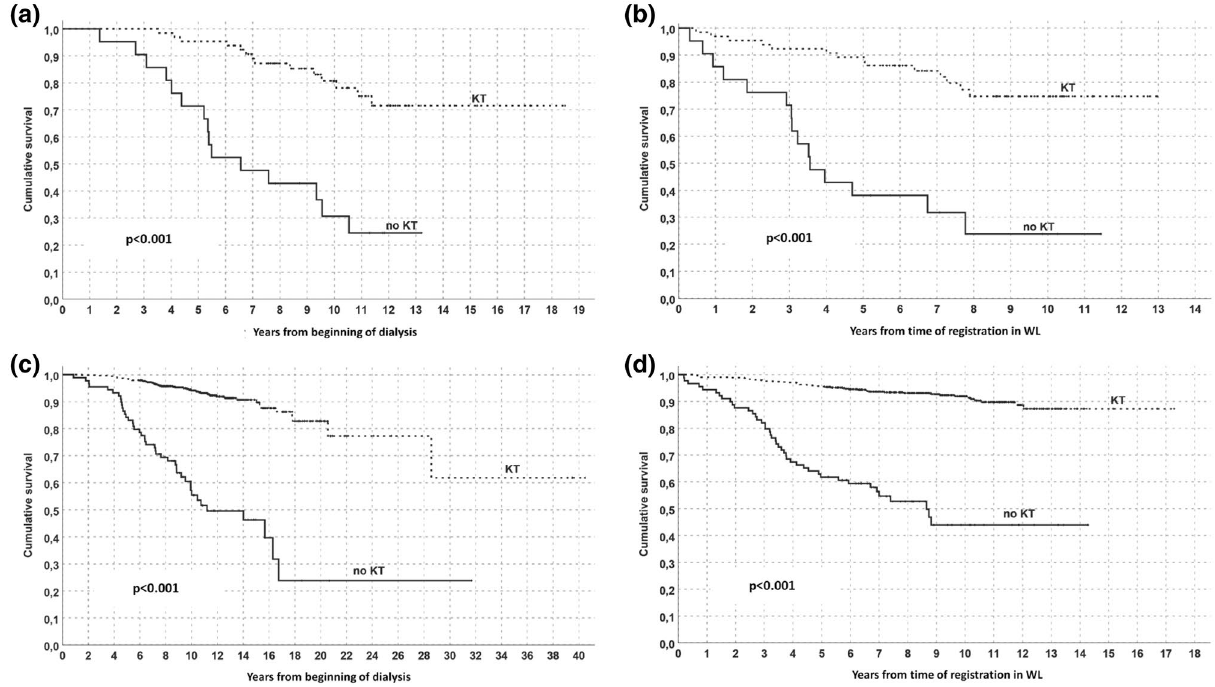
Figure 3. Survival analysis in T2D ( a , b ) and non-T2D ( c , d ) group (Kaplan–Meyer) according to kidney transplantation or maintenance on WL. Follow/up start in ( a ) and ( c ) at the beginning of dialysis or in ( b ) and ( d ) at time of registration in WL. T2D (n = 15) Non-T2D (n = 43)